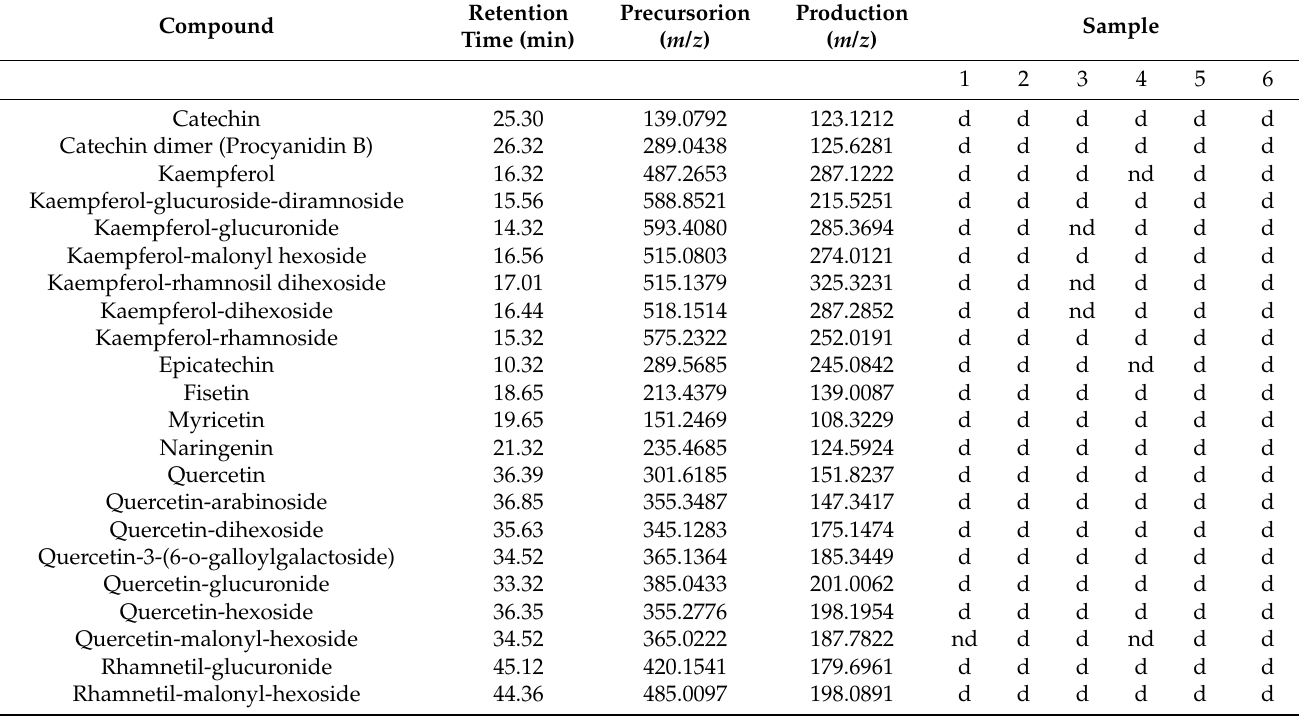
Table 2. Flavonoids detected in extracts of defatted Willamette, Polka, and Meeker raspberry seeds, obtained using UAE under optimal conditions and